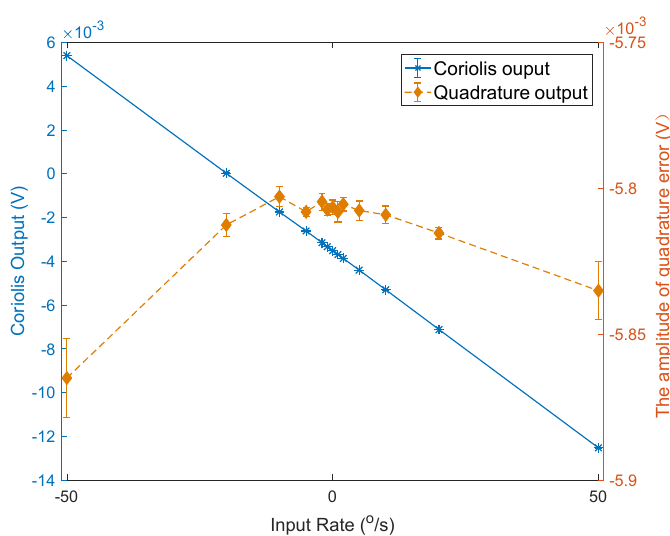
Figure 11. The variation curves of the Coriolis signal and the amplitude of the quadrature error signal with the input angular velocity.